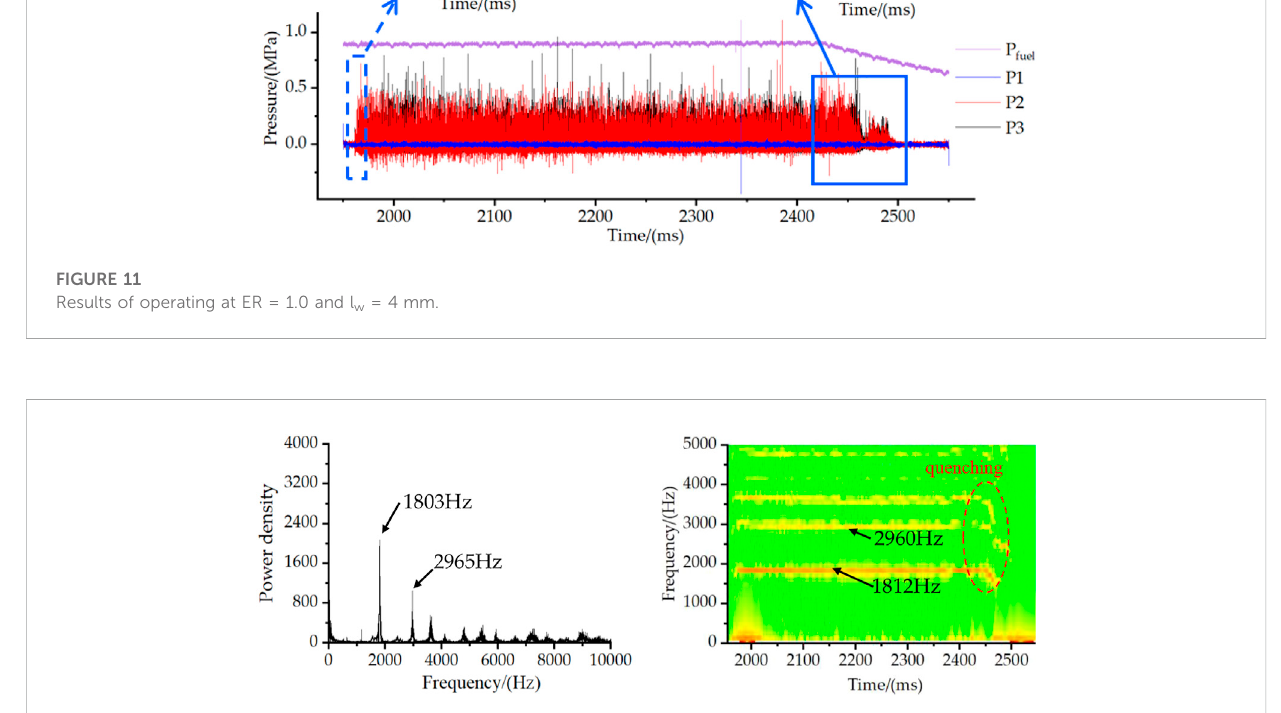
FIGURE 12 Results of FFT and STFT by P 3 at ER = 1.0 and l w = 4